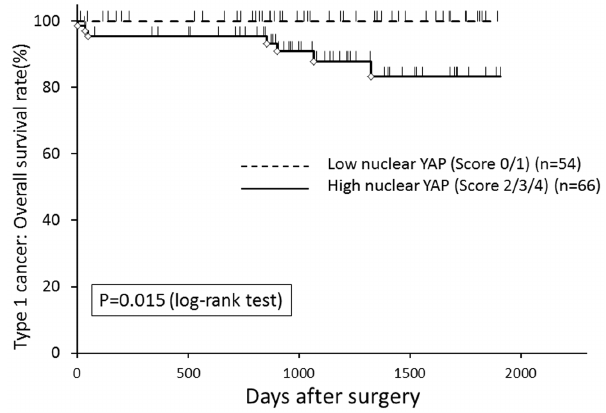
Figure 1. The Kaplan-Meier curve for overall survival rate of patients with type 1 EMCA (n=120) according to the nuclear expression of YAP. Increased nuclear immunoreactivity of YAP was significantly associated with worse overall survival (P=0.015, log-rank test).